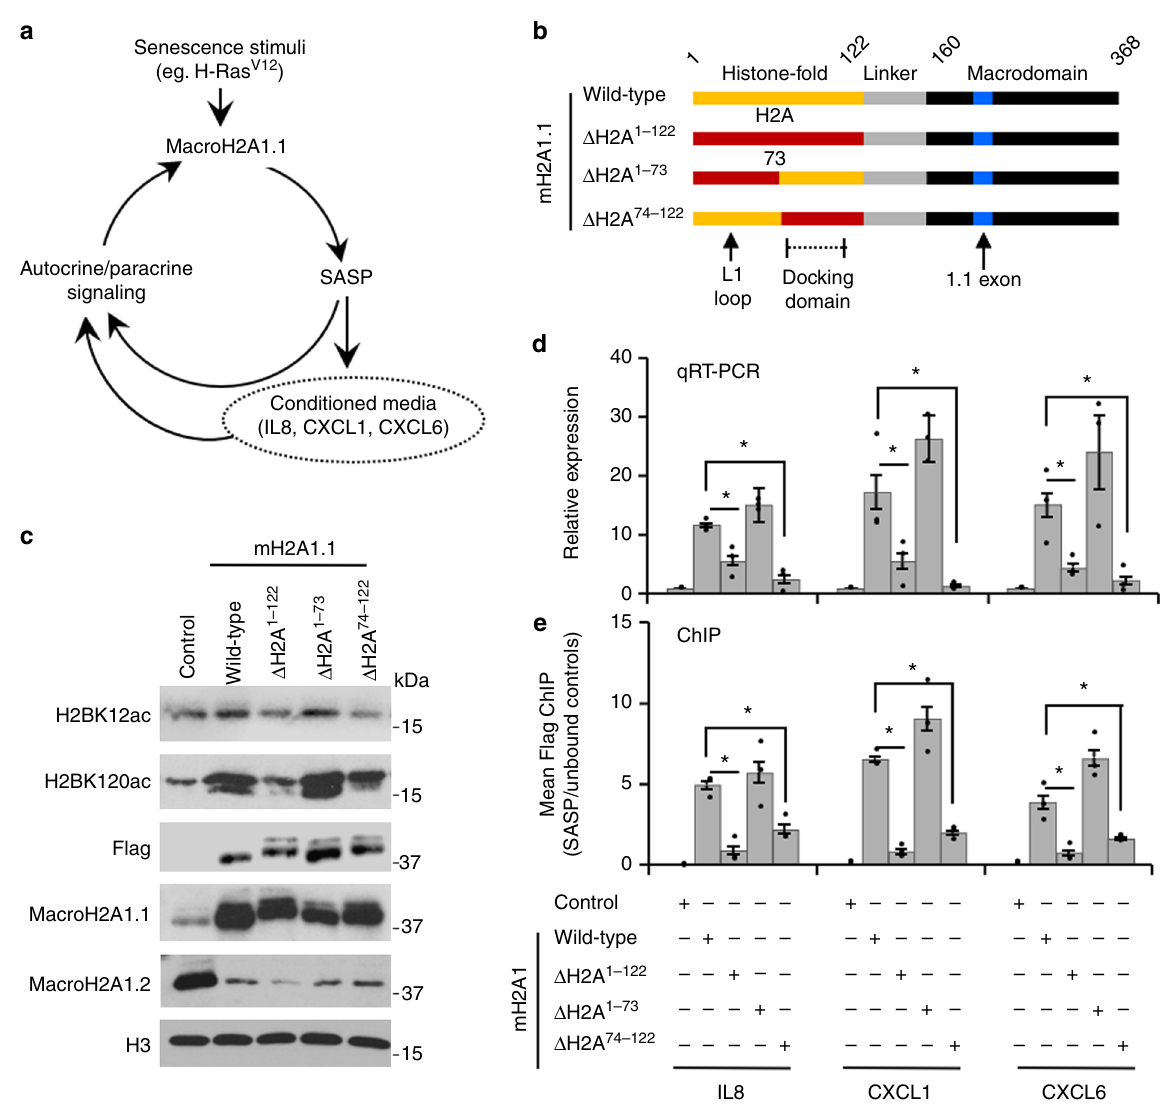
Fig. 2 MacroH2A1 localization to H2Bac chromatin is required for regulation of H2BK12ac, H2BK120ac, and SASP gene transcription. a Diagram illustrates macroH2A1.1-dependent positive feedback loop regulating the induction of SASP gene expression. Senescent stimuli, such as H-Ras V12 upregulates the expression of macroH2A1.1 which promotes the transcription of SASP genes. Secreted SASP factors can act in an autocrine or paracrine fashion. Conditioned media from senescent cells contains secreted cytokines and chemokines (SASP factors) which can promote senescence through paracrine signaling. b Schematic of domain swap macroH2A1.1-Flag (mH2A) mutant lentiviral constructs expressed in IMR90-hTERT cells. MacroH2A1.1 exon and docking domain indicated. c Immunoblots of acid-extracted histones for indicated histones and histone PTMs from cells that ectopically express macroH2A1.1 constructs described in b . d RT-qPCR for SASP factors of cells described in b . Error bars, s.e.m. ( n = 3 independent lentiviral infections, * p < 0.05 from a two- tailed Student ’ s t -test). e Flag ChIP-qPCR in macroH2A1.2-Flag cells for SASP genes shown in d . Bars represent enrichment of macroH2A1-Flag at SASP loci over unbound control regions. Error bars, s.e.m. ( n = 3 independent cell passages, * p < 0.05 from a two-tailed Student ’ s t